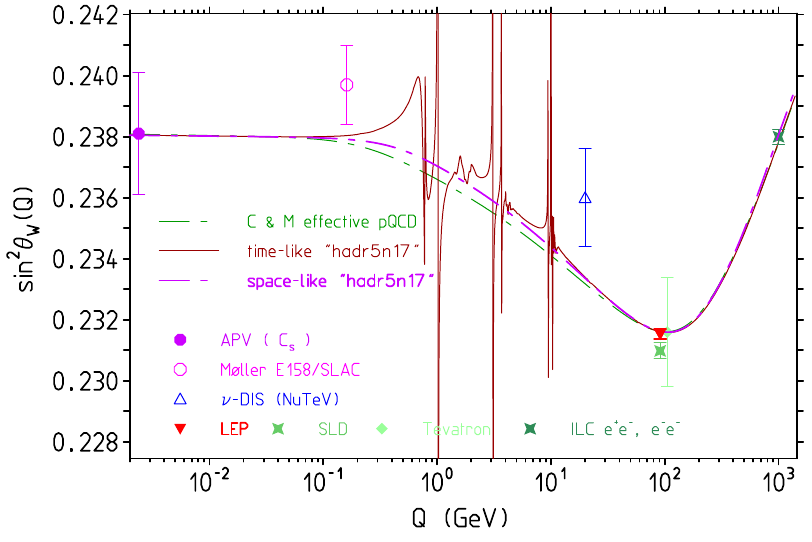
Figure 1. sin 2 Θ W ( Q ) as a function of Q in the time-like and space-like region. Hadronic uncertainties are included but barely visible in this plot. Uncertainties from the input parameter sin 2 θ W (0) = 0 . 23822(100) or sin 2 θ W ( M 2 ) = 0 . 23153(16) are not shown. Note the substantial di ff erence from applying pQCD with e ff Z